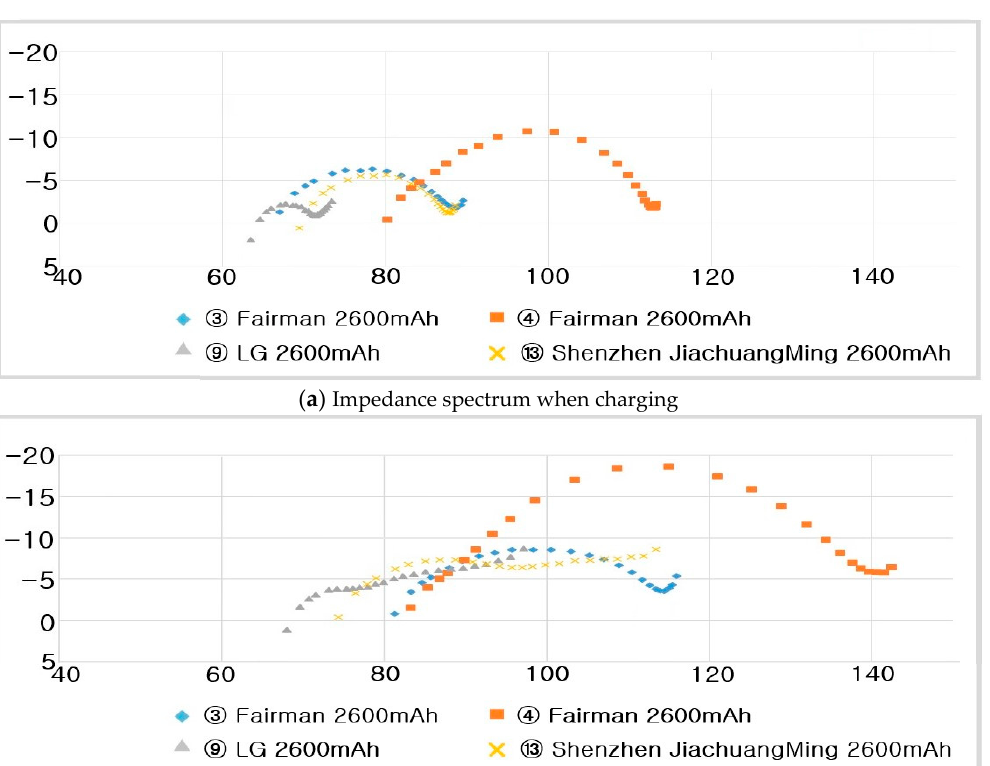
Figure 20. Impedance spectra of 2600 mAh 18650-type Li-ion batteries (built-in protection